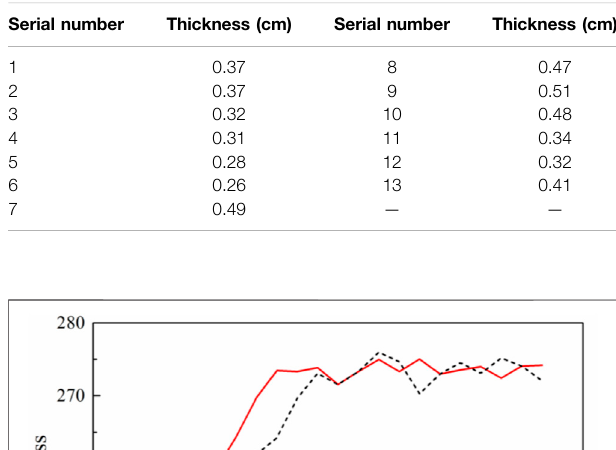
TABLE 2 | Optimized thicknesses of slabs.